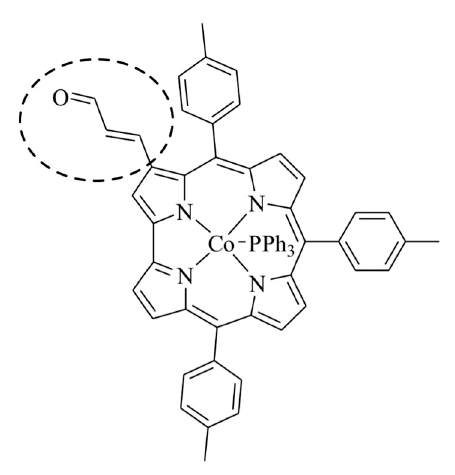
Figure 1. Scheme of the acrolein functionalized [5,10,15-tris-(4-methylphenyl)corrolato]Cobalt(III). Dotted circle evidences the acrolein group necessary to include the molecule in the polyacrolein.